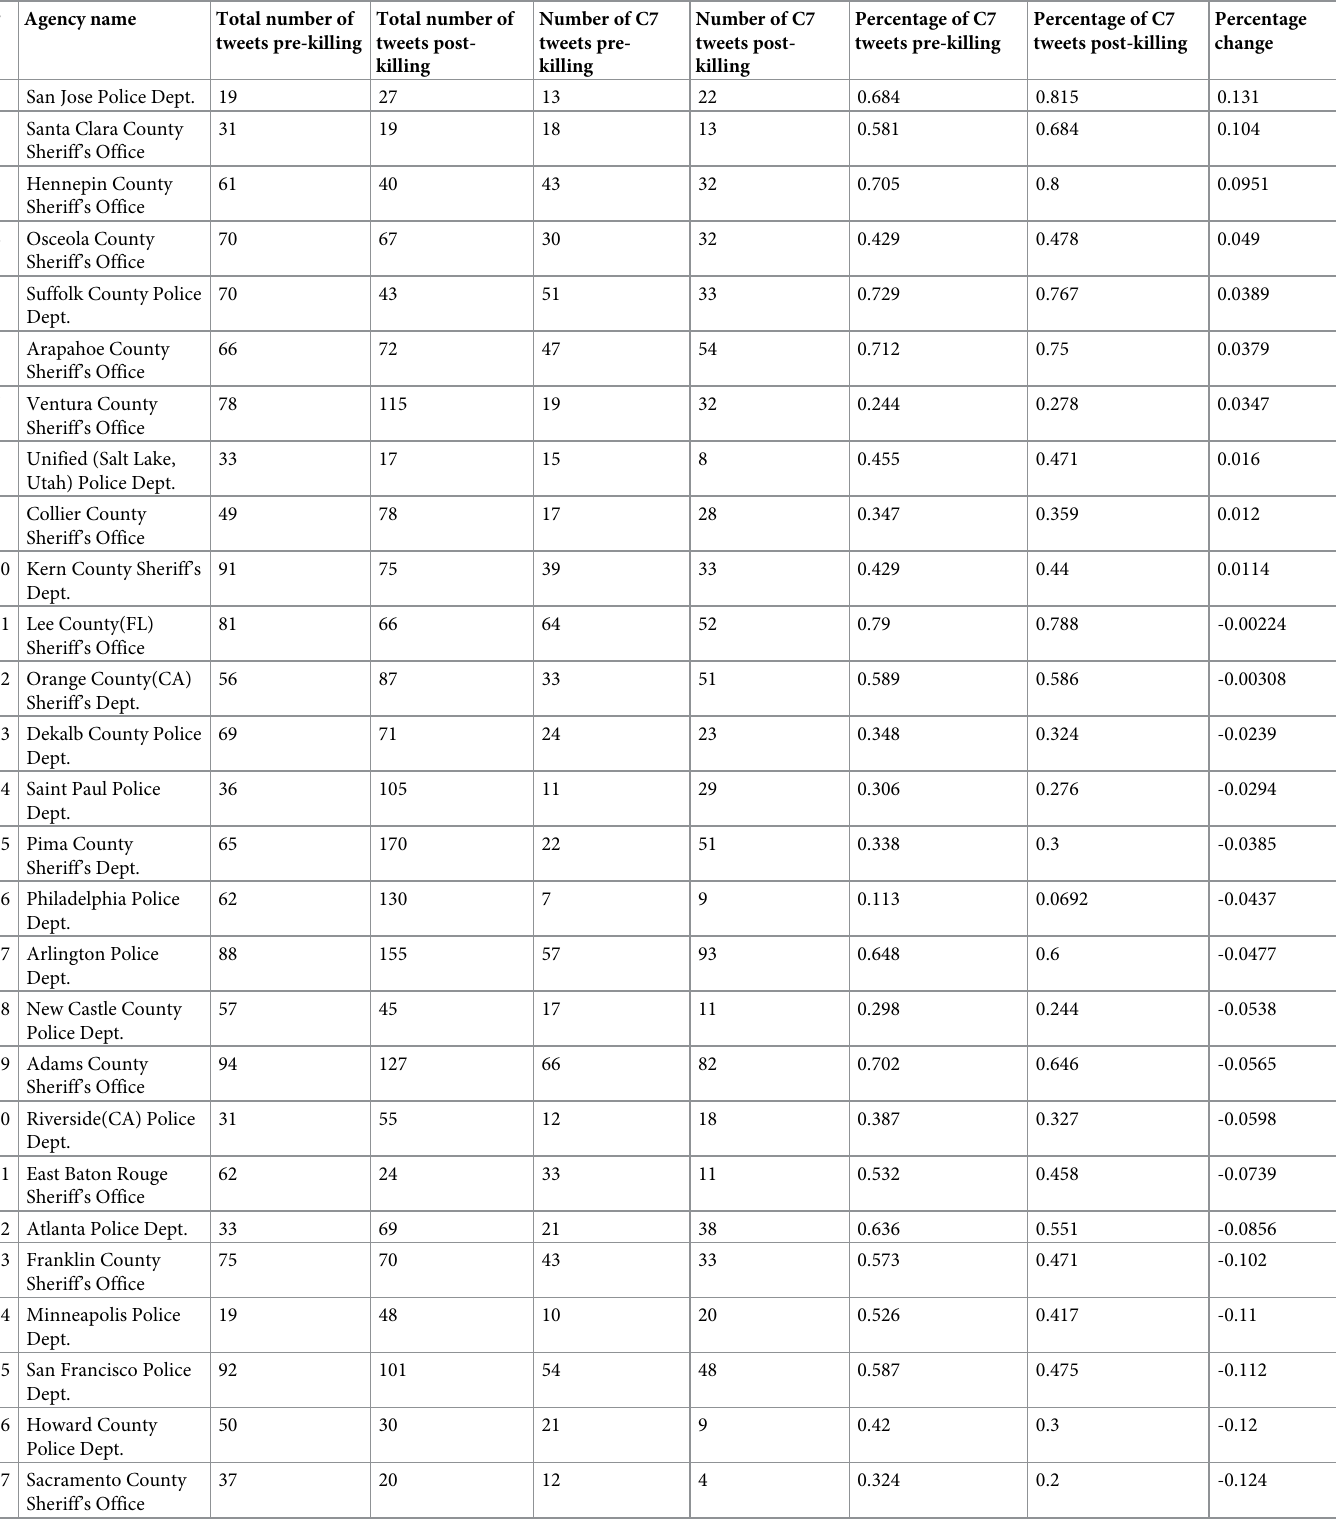
Table 12. Agencies (in the lower-use group) ranked by the increase in posting category 7 (community engagement and outreach) tweets before and after the killing. # Agency